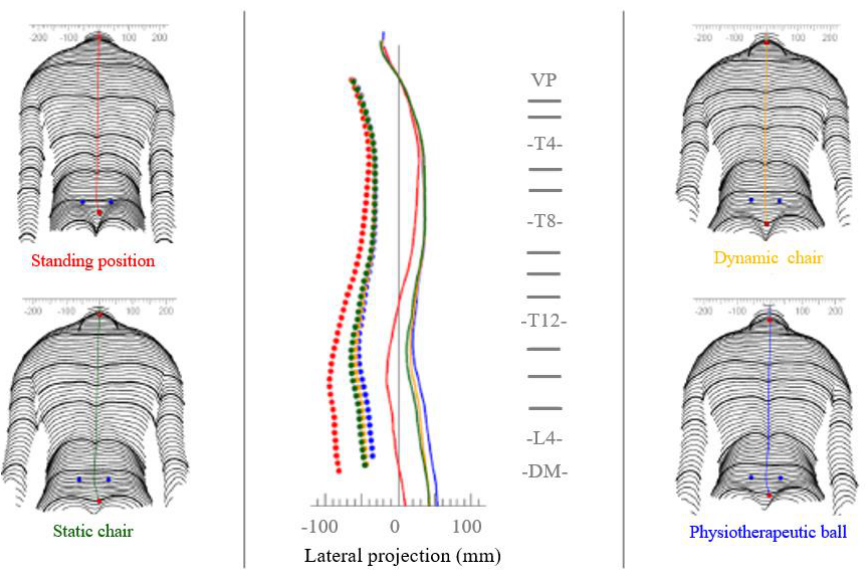
Figure 12. Comparison of the spine curvature during sitting on various types of chairs and in the standing position.